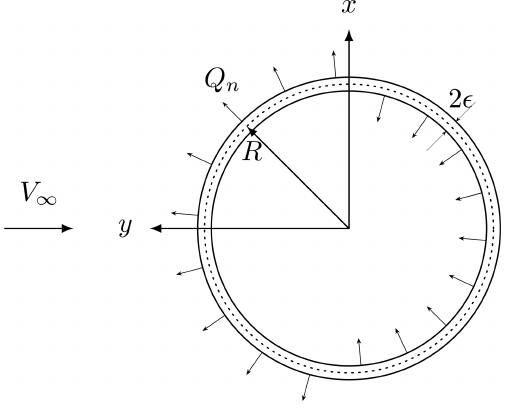
Figure 1. Radial forces acting on